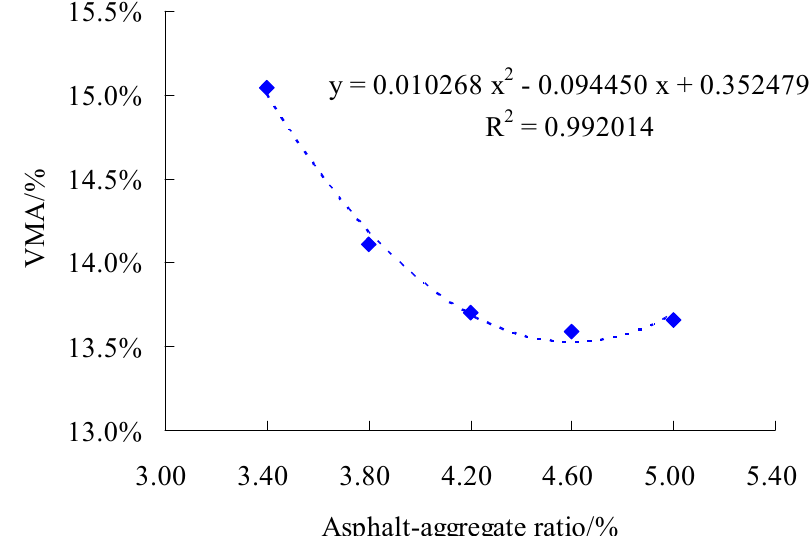
Figure 8. Test results of VMA at different asphalt–aggregate ratios.